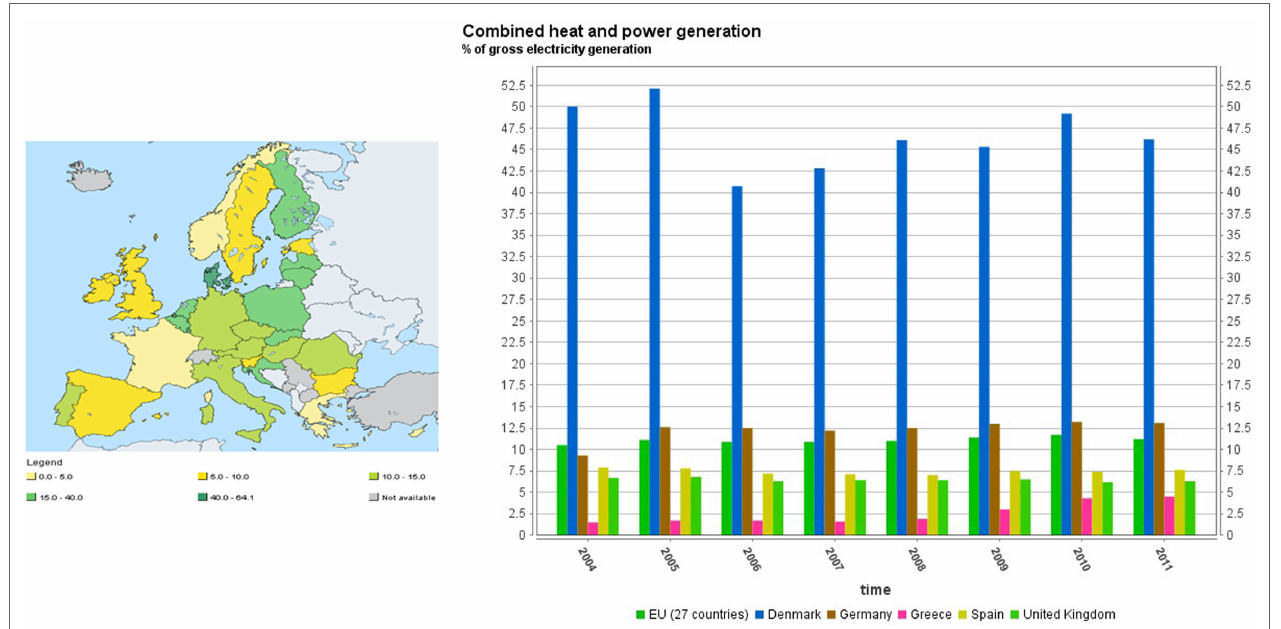
FIGURE 1 | (Left) CHP % generation of gross electricity generation (EUStat) .